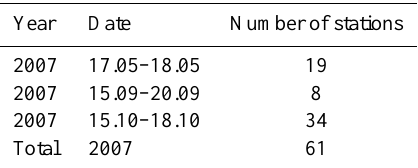
Table 2. Period of observations and number of hydrographic pro- files obtained on the north-western